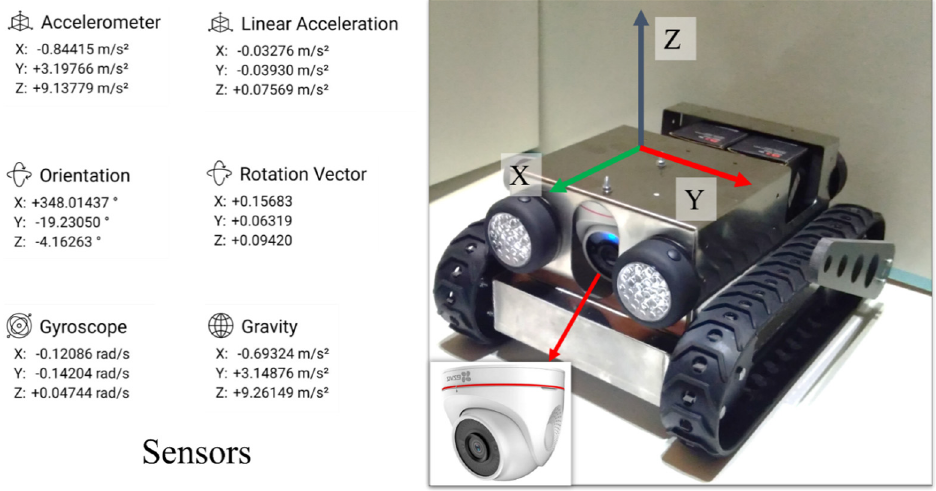
Figure 3. Scheme for the internal sensor suite composed of a front camera, led lights, an accelerometer, a linear accelerometer, a sensor for orientation and rotation, a gyroscope, and a gravity sensor. The reference system is given in the scheme.